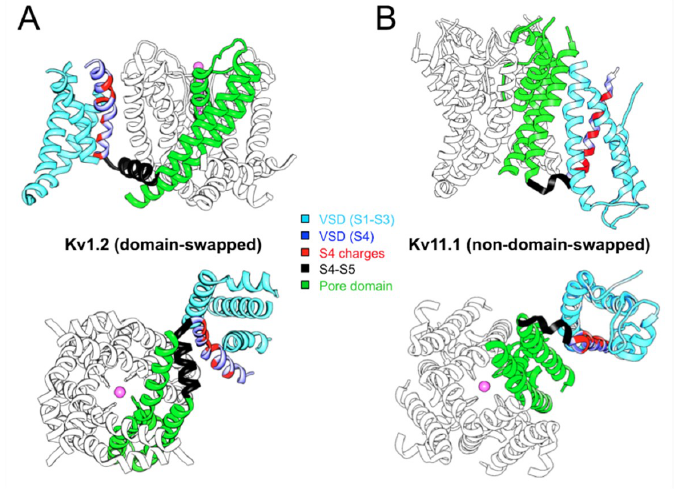
Figure 1. Comparison of domain-swapped ( A ) and non-domain-swapped ( B ) architectures of Kv channel transmembrane domains. Only a single VSD is shown attached to the tetramer of the PD for clarity. One complete subunit is shown colored as indicated. The magenta balls indicate the position of K + ions in the selectivity filter. Note the different length of the S4–S5 linker determining the VSD contact with the neighboring ( A ) or the same ( B ) subunit. Structures viewed from the membrane plane (top) and from the cytoplasmic side (bottom) are shown for Kv1.2 (PDB: 2A79) and Kv11.1 (hERG, PDB: 5VA2).